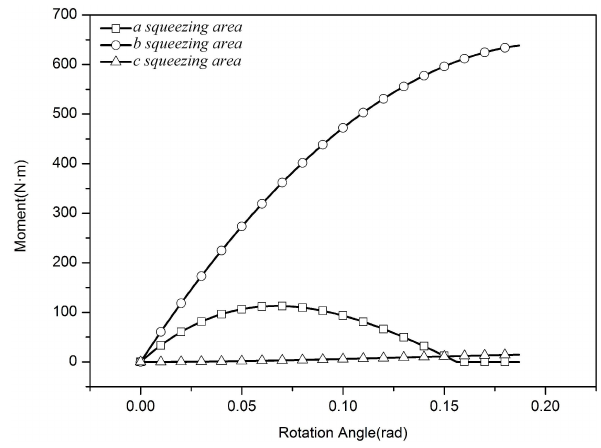
Figure 7: Contribution of each squeezing area to the moment